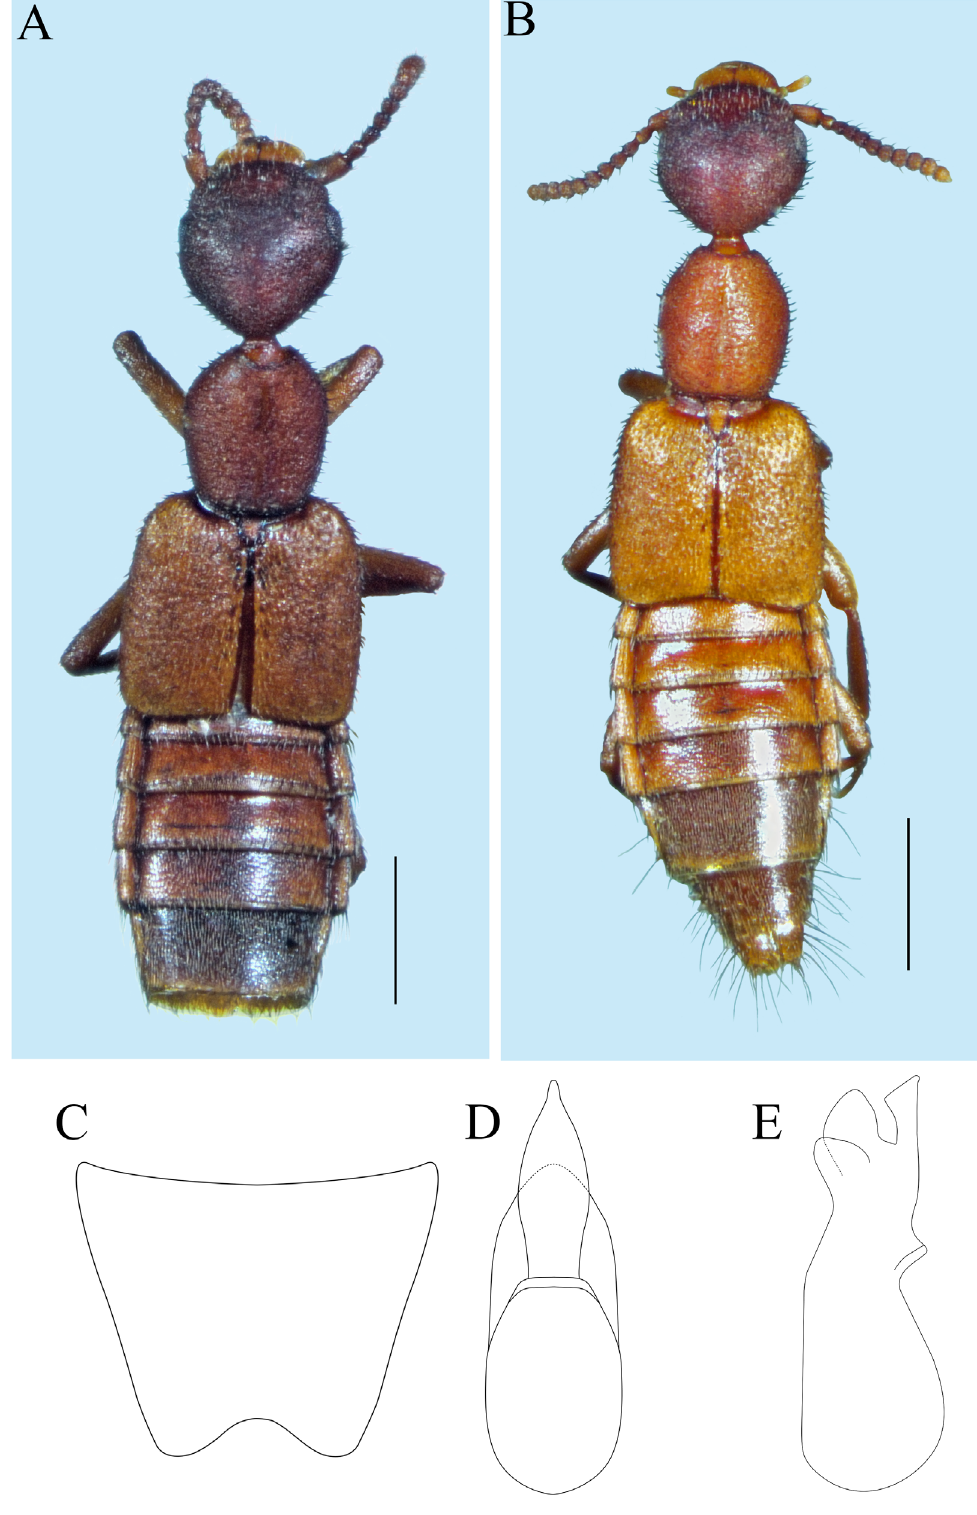
Fig. 2. Morphology of Megastilicus iowaensis sp. nov. A . Dorsal habitus of holotype (NMNH). B . Dorsal habitus of paratype (NMNH). C . Sternum VIII. D . Aedeagus in parameral view. E . Aedeagus in lateral view. Scale bars = 1